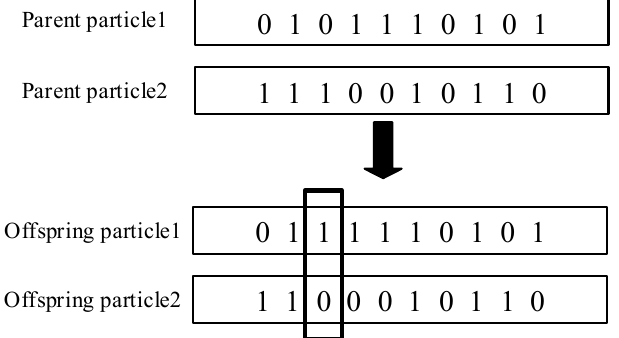
Figure 7. Genetic algorithm crossover operation diagram.